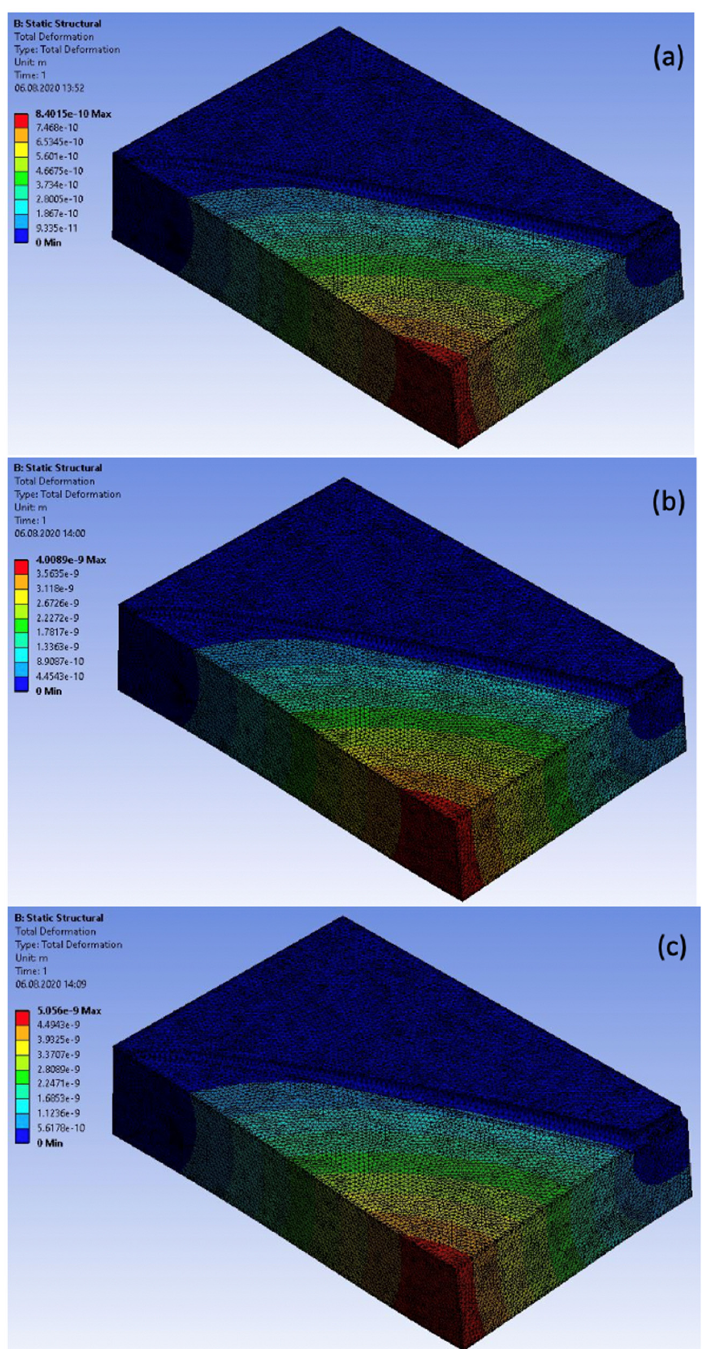
. m 1 = 0.011488 kg/s,